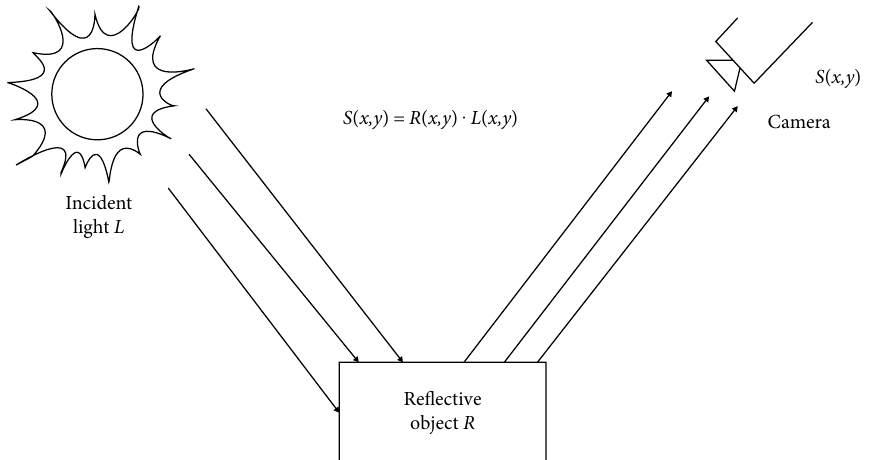
Figure 1: Schematic diagram of Retinex